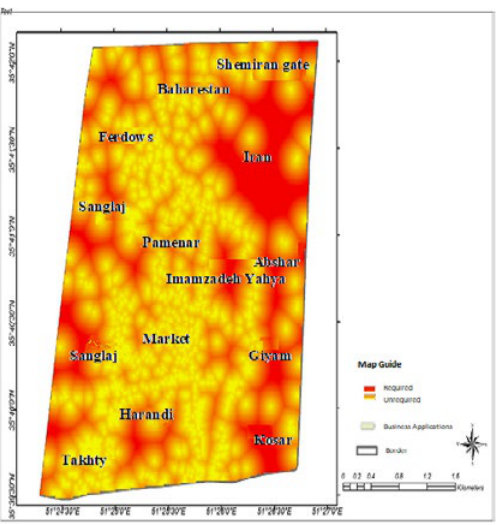
Fig. 19: Fuzzy distance layer from economic centers of the District 12 Fig. 20: Green spaces map of the District